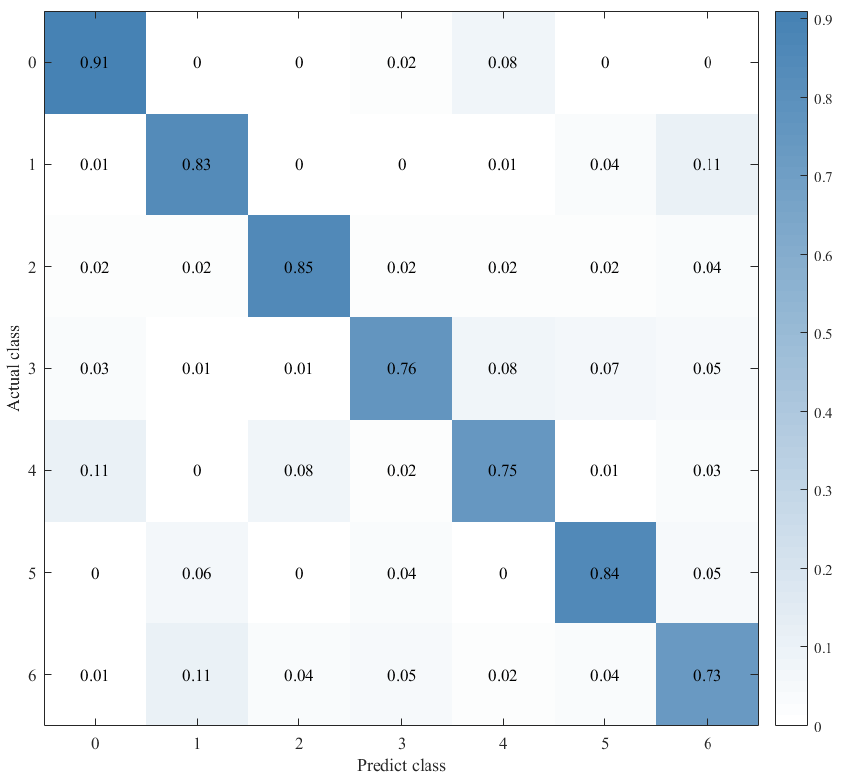
Figure 14. Confusion matrix for CNN+LSTM×2.